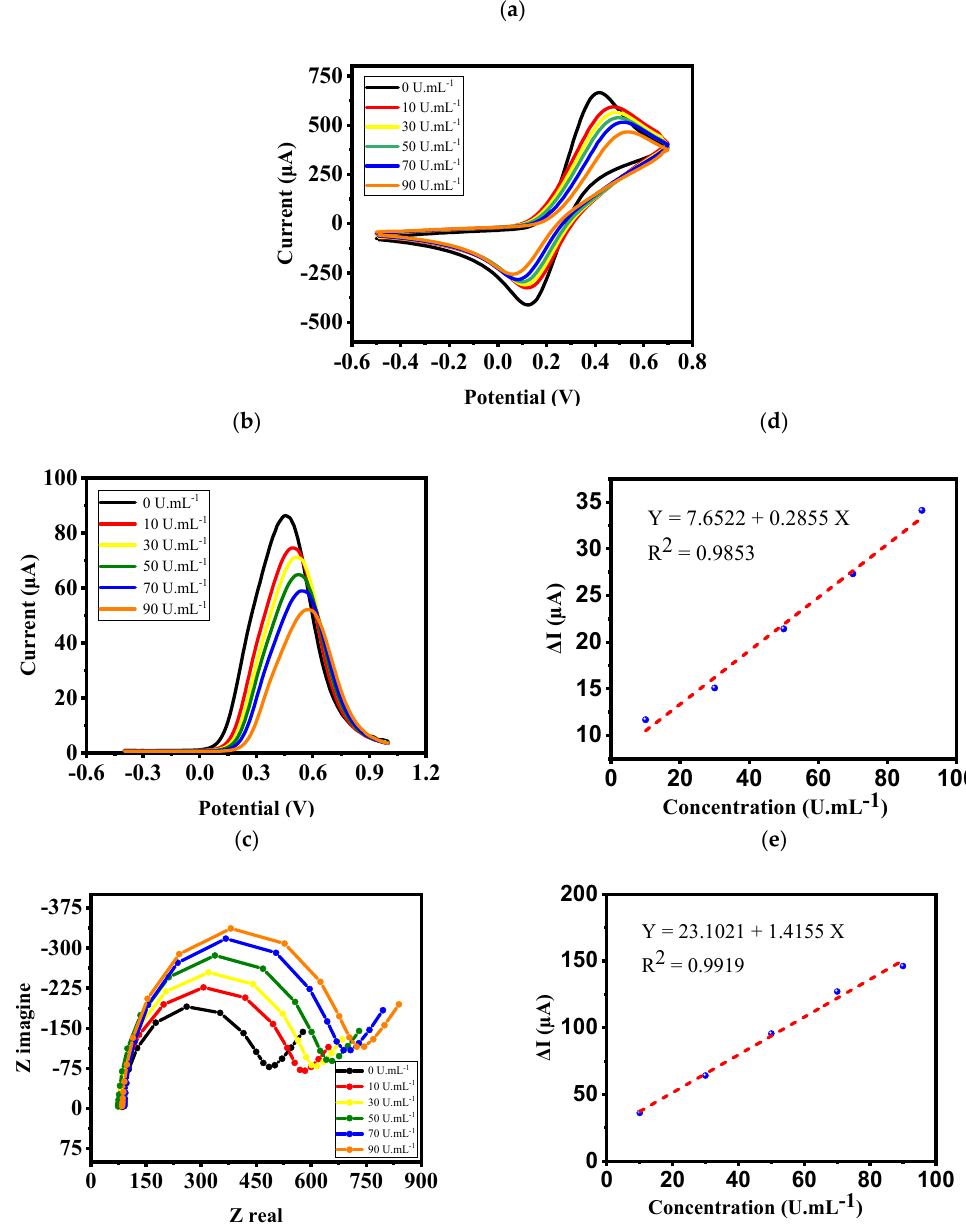
Figure 5. ( a ) CV analysis, ( b ) SWV voltammograms, and ( c ) Nyquist diagrams of the electrode in ] − 3 / − 4 (0.2 mM) media at different concentrations of CA 15-3 ranging from 0 to 90 UmL − 1 . K 4 [ Fe ( CN ) 6 ( d , e ) CV and SWV linear responses of the nanoprobe to different concentrations of CA 15-3. Even though potassium ferrocyanide has a good electrochemical signal, it is